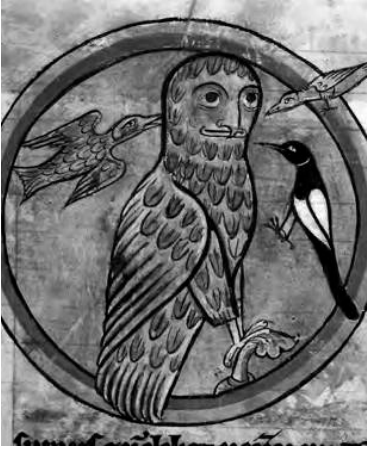
Figure 5. An owl attacked by birds. Bestiary, England, second quarter of the thirteenth century; London, © British Library Board, MS. Harley 4751, fol. 47r. Used by